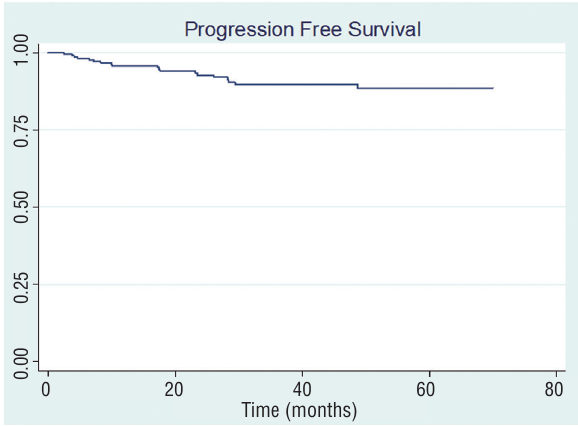
Figure 2 - Kaplan-Meier curve of progression free